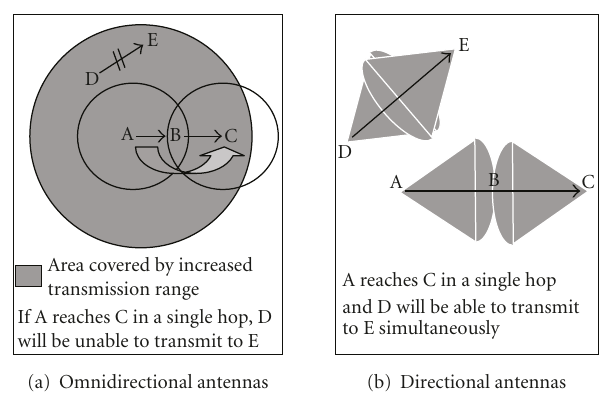
Figure 4: Number of hops in a route.